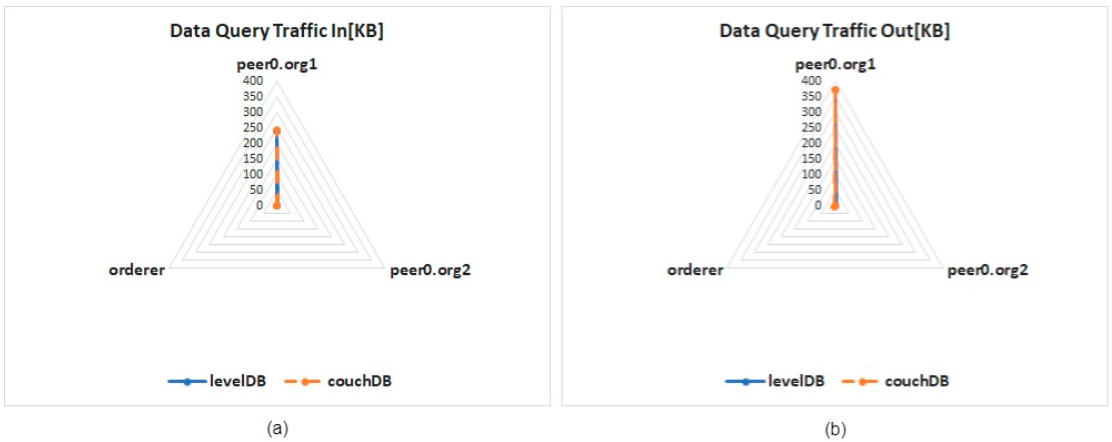
Figure 15. Network traffic for a single data query: ( a ) incoming packets, ( b ) outgoing packets.